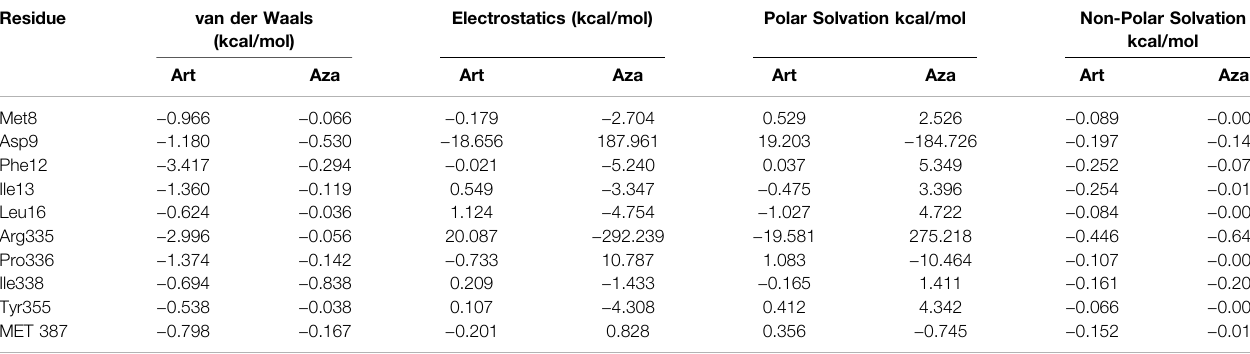
TABLE 1 | Energy contributions between the active site residues of Gephyrin E and Artesunate and Azadirachitin.